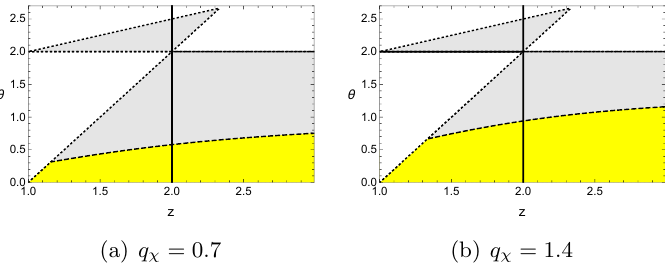
Figure 21 . Sign of the coe(cid:14)cient of q 2 of the transverse resistivity near q 2 = 0. Yellow region 2 denotes positive sign(WL) and gray region is for negative sign(WAL). Dotted line is NEC. Here we use the same parameters as (cid:12)gure 18 and T = 0 :